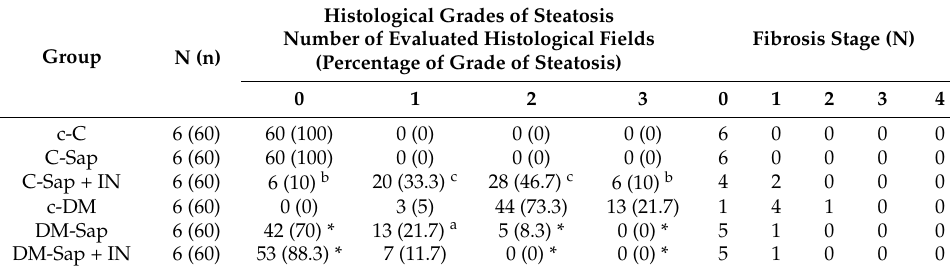
Steatosis data are expressed as counts and percentages (in parentheses). N: number of animals; (n): number of